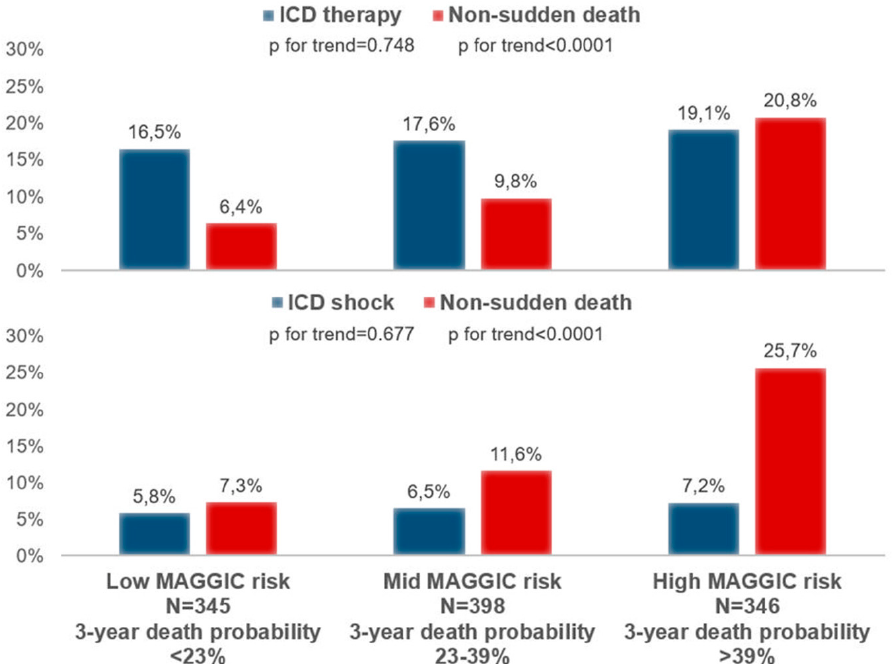
Figure 1. Frequency of ICD therapy or shock and non-sudden death by tertiles of 3-year death probability estimated using the MAGGIC score.